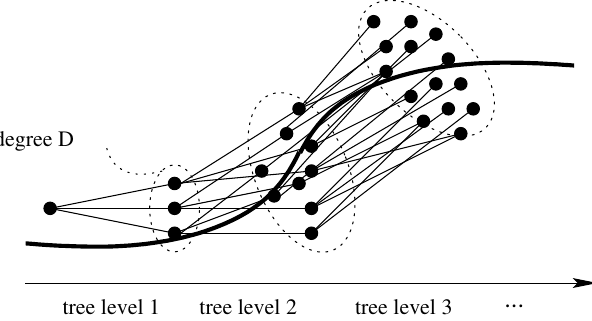
Figure 3. A random tree exploring the area around a given trajectory. In the representation, the degree of the tree is equal to D = 3, so is its height H